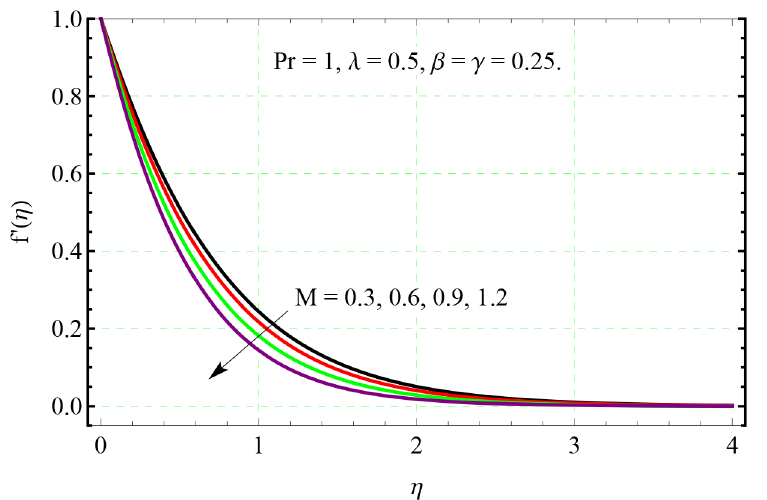
Fig 7. Effect of M on f 0 ( η ).